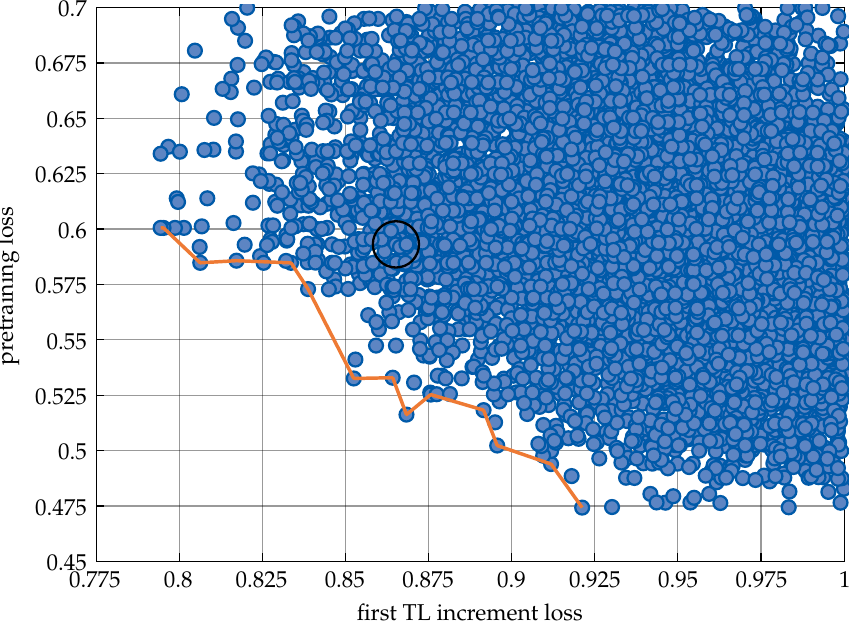
Figure 6. Pareto front and the optimum (black circle), which is selected based on further objective functions.